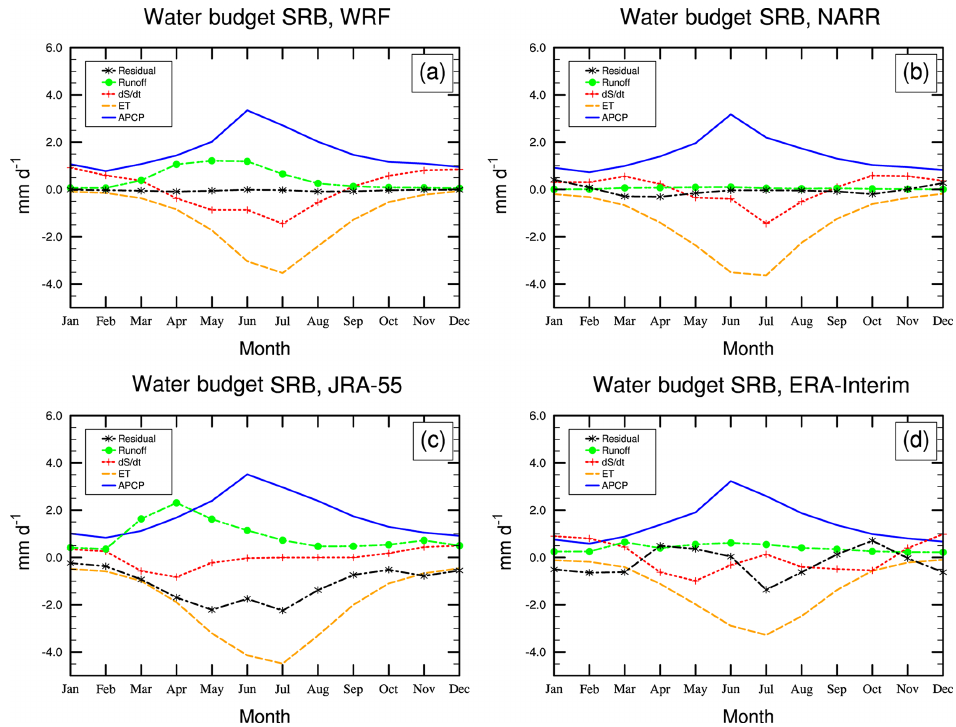
Figure 3. The surface water budget (mmd − 1 ) in SRB from WRF–CTL and the reanalysis datasets (NARR, ERA-Interim, and JRA-55). ET denotes evapotranspiration. APCP denotes accumulated precipitation per time